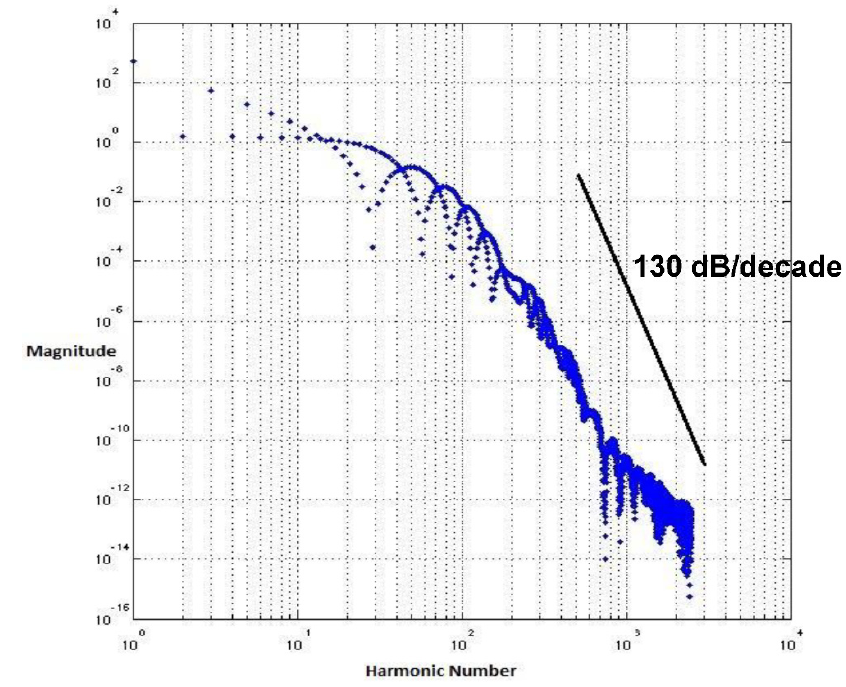
Figure 10. Spectrum roll-off of HLFF using the 65 nm process.